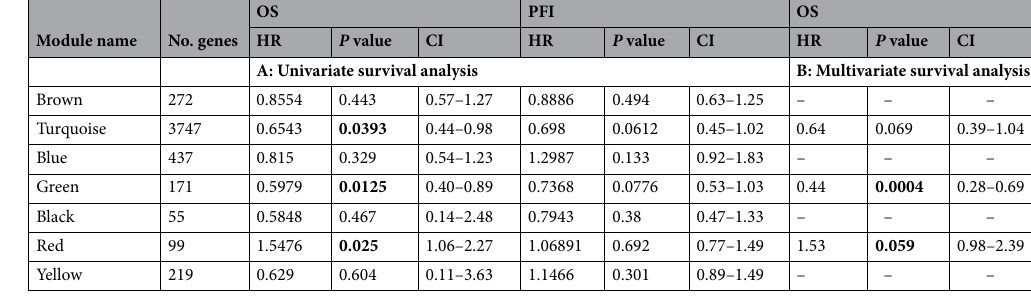
Table 1. A: Univariate survival analysis for gene co-expression modules with overall survival (OS) and progression-free interval (PFI) as endpoints. B: Multivariate Cox regression among Turquoise, Green, and Red modules. A value of 0.05 for the P value was defined as the threshold. Significant modules were indicated with the bold P value.